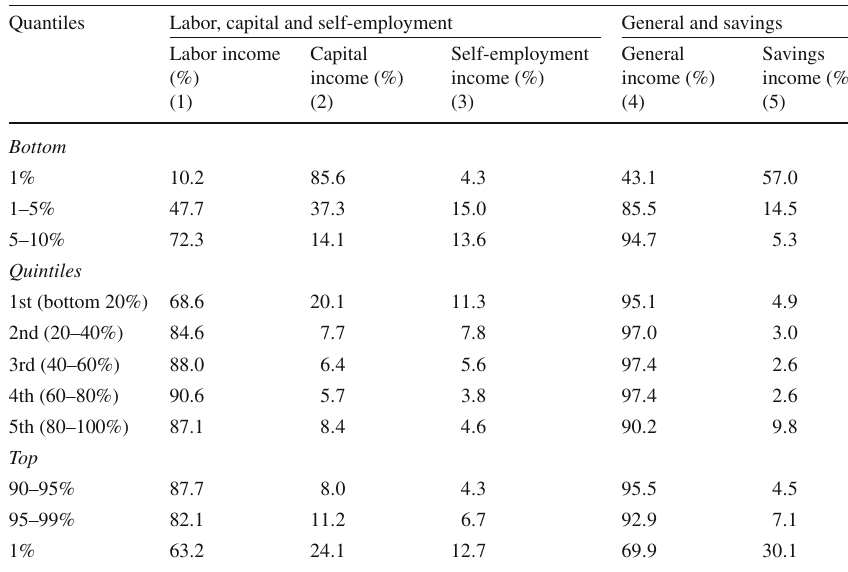
Table 5 Individual gross income sources (2015)